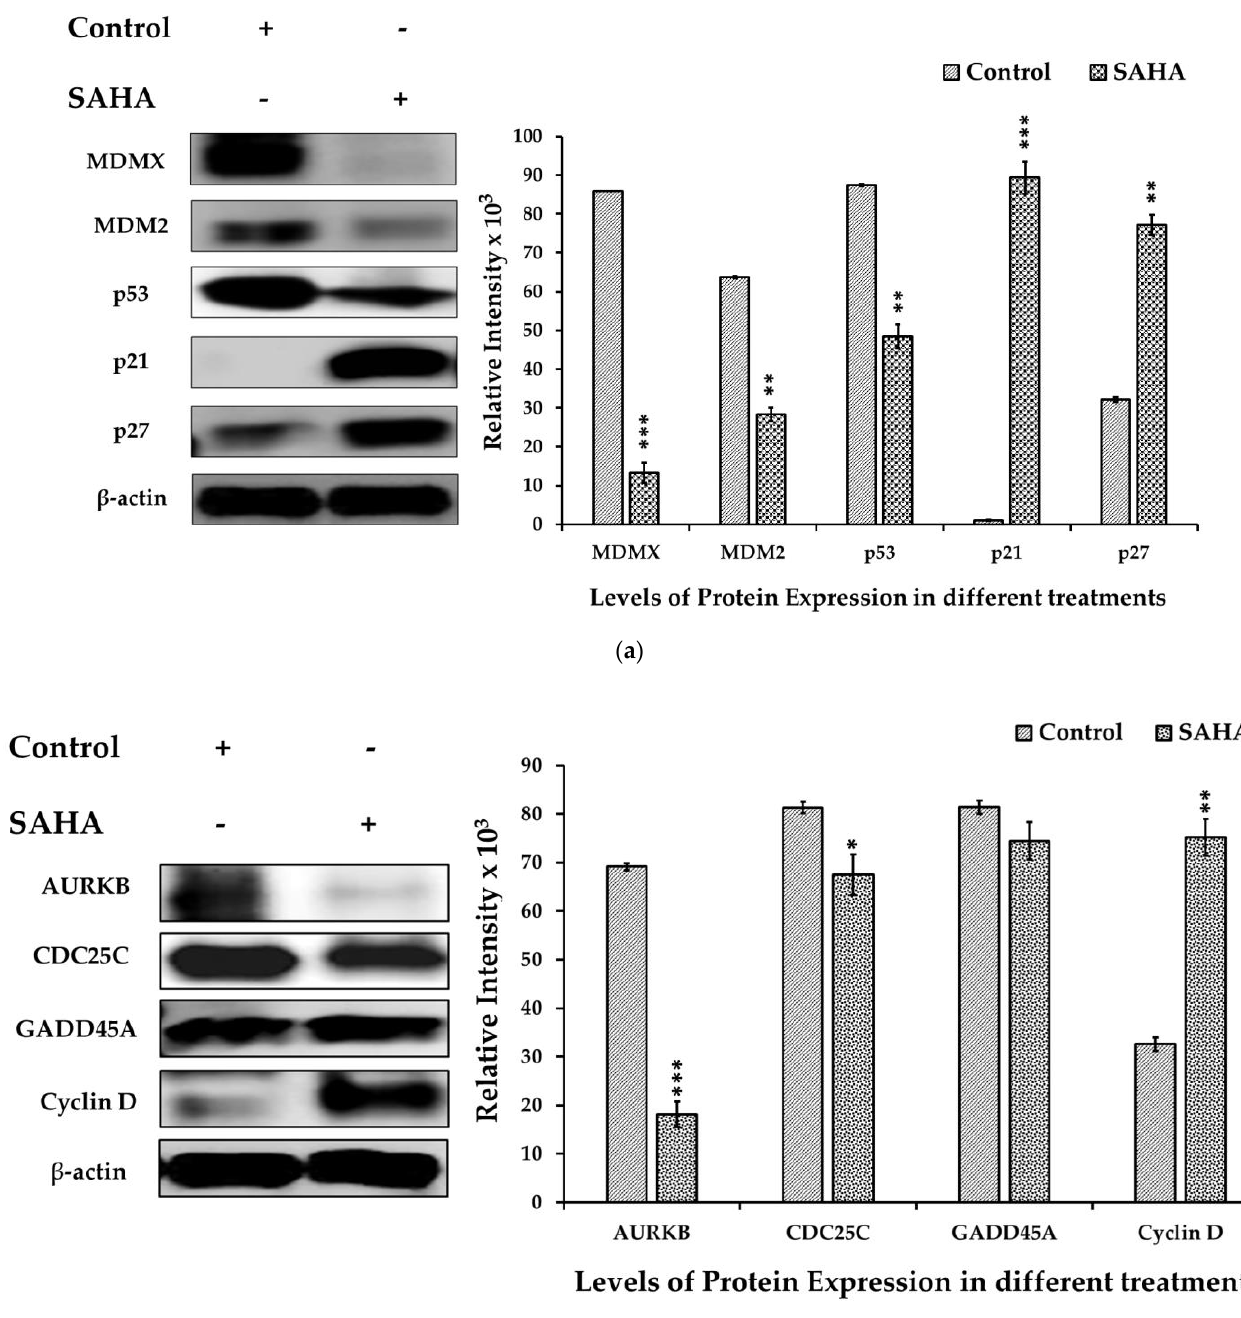
Figure 5. ( a ). SAHA induced cell cycle arrest in A2780 cells. The levels of cell cycle protein expression in the A2780 cells were measured by immunoblot analysis. MDMX, MDM2, and p53 expression levels were significantly decreased, and p21 WAF1/CIP1 and p27 Kip1 levels were increased in the SAHA (7.5 μM) treated cells compared with the untreated control. The bar graphs represent cell cycle-related protein levels following treatment with SAHA, as determined by densitometry of bands. All data are presented as the mean ± SD of at least 3 independent experiments. ** p < 0.01; *** p < 0.001. ( b ). Changes in the expression level of various cell cycle markers in A2780 cells. AURKB levels were significantly reduced, and CDC25C levels were also slightly diminished in SAHA (7.5 μM) treated cells compared with the control. The bar graphs represent other cell cycle-related protein levels following treatment with SAHA, as determined by densitometry of bands. All data are presented as the mean ± SD of at least 3 independent experiments. * p < 0.1; ** p < 0.01; *** p < 0.001.